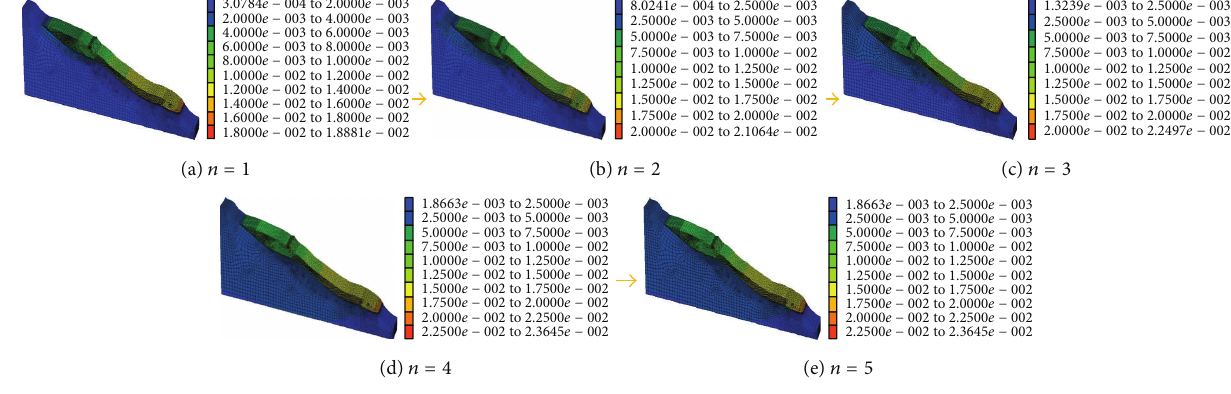
Figure 12: Nephogram of slope displacement in 𝑋 direction.